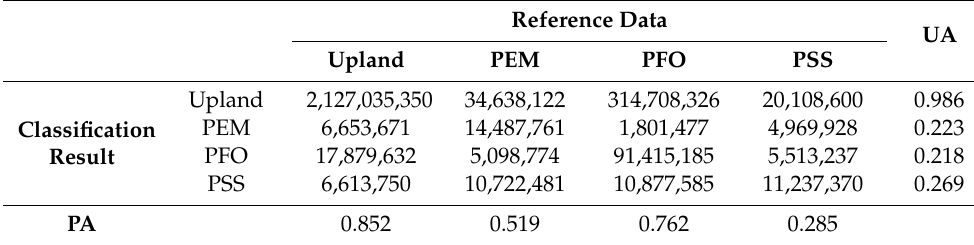
Table 8. Results for multiclass classification with a distance weighting index of 1 (equivalent to a linear increase in with distance from the edge). OA = 0.836, Kappa = 0.330, AD = 0.038, QD =